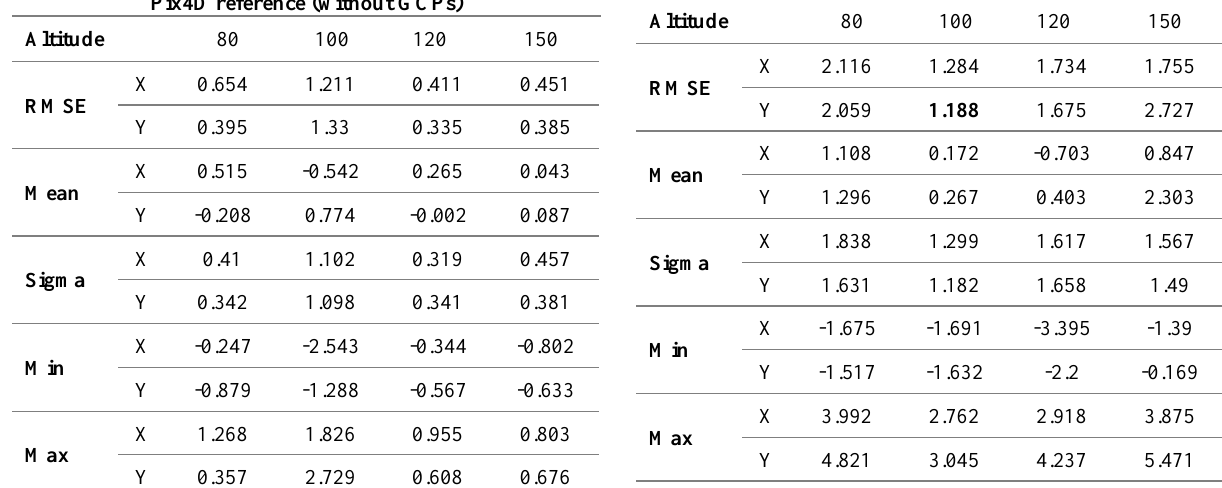
Pix4D reference (without GCPs)